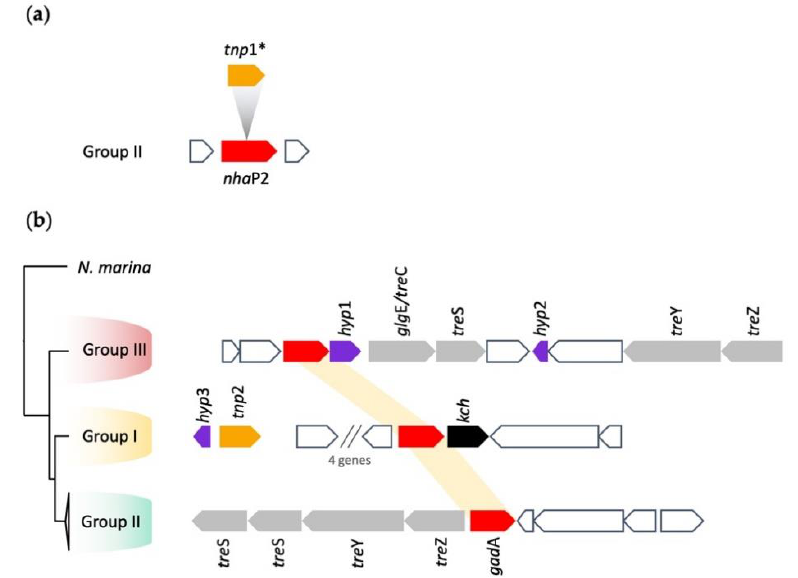
Figure 7. Gene context of ( a ) nhaP 2 showing conservation in all strains of Group II. Color coding of genes: red = nha P2, orange mobile element tnp 1 (transposase DDE_3; pfam13358) found only in strain ML-04. ( b ) Phylogenetic distribution of gad A in all Leptospirillum Groups. Color coding of genes: red = gad A, purple = orphan hypothetical genes, grey = conserved genes predicted to be involved in trehalose biosynthesis, orange = mobile element ( tnp 2 (PHA02517), black = kch , potentially involved in acid resistance (see Section 3.4.1), and white = other genes.